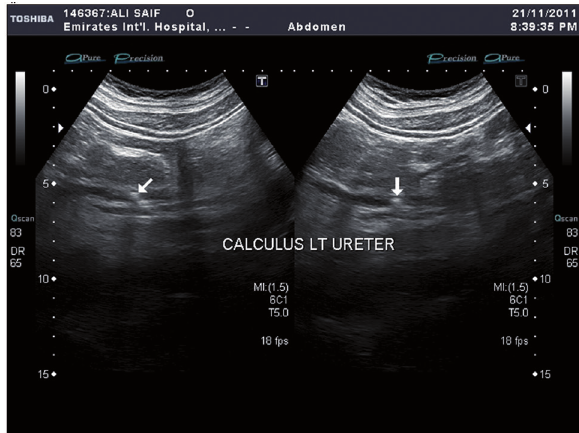
Figure 1A - Grey scale ultrasound of stone in the left middle ureter with posterior shadowing.